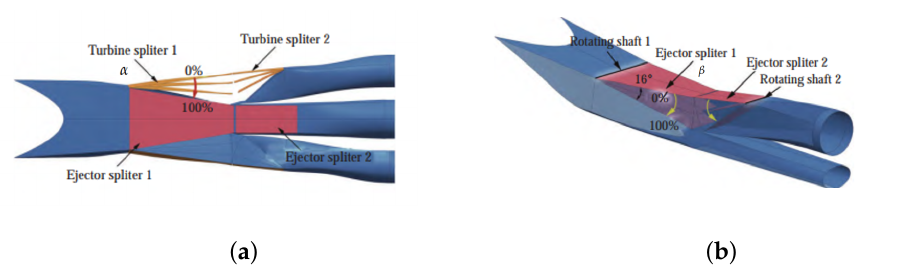
Figure 2. ( a ) Top view of XTER combined air inlet; ( b ) Side view of XTER combined air